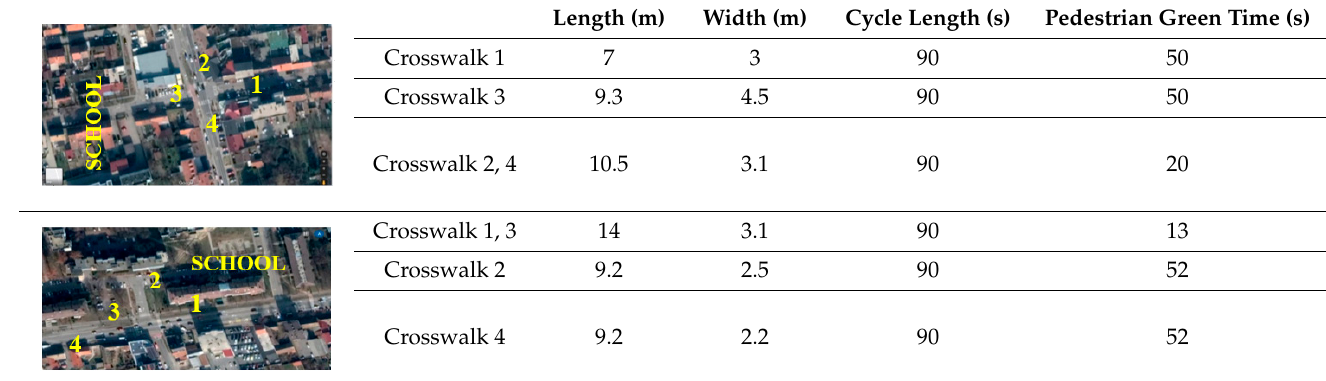
Table 2. Basic characteristics of crosswalks in Osijek, Croatia.